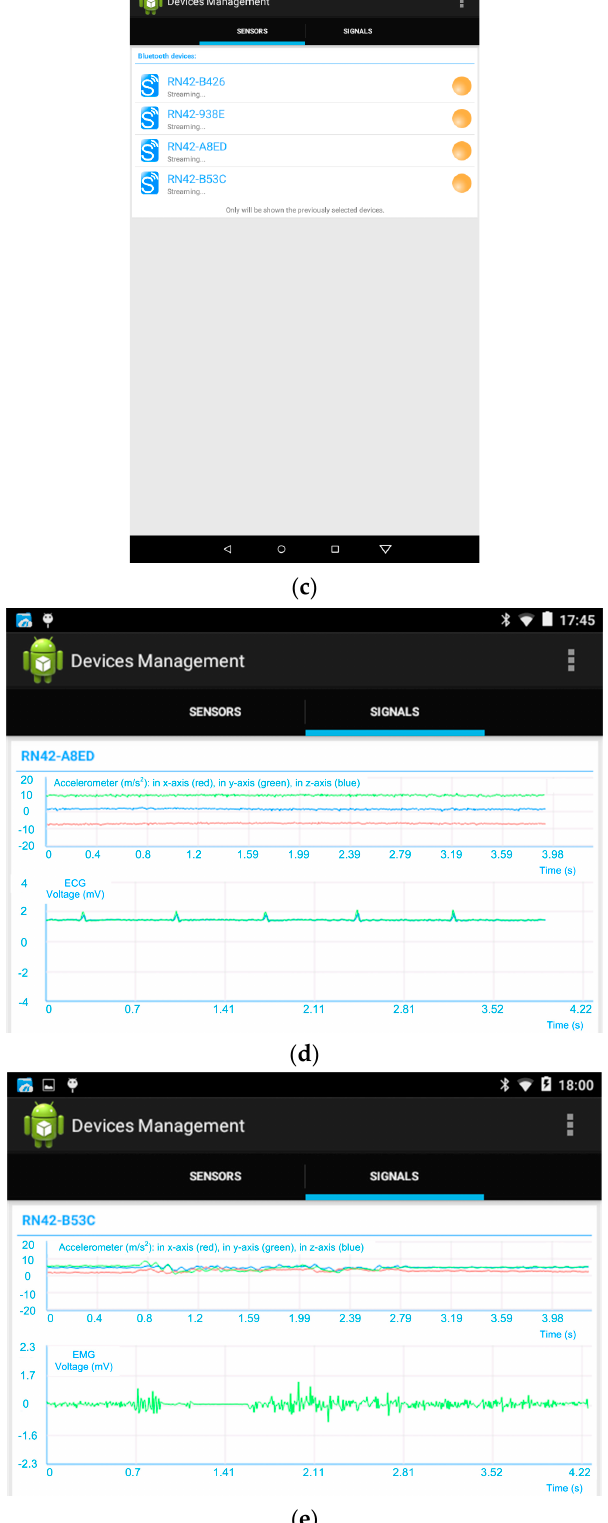
Figure 4. Five screens of the Graphical User Interface (GUI) of the application: ( a ) First screen of the GUI; ( b ) Second screen of the GUI; ( c ) Third screen of the GUI; ( d ) Fourth screen of the GUI with the accelerometer and ECG graphs; ( e ) Fourth screen of the GUI with the accelerometer and EMG graphs.